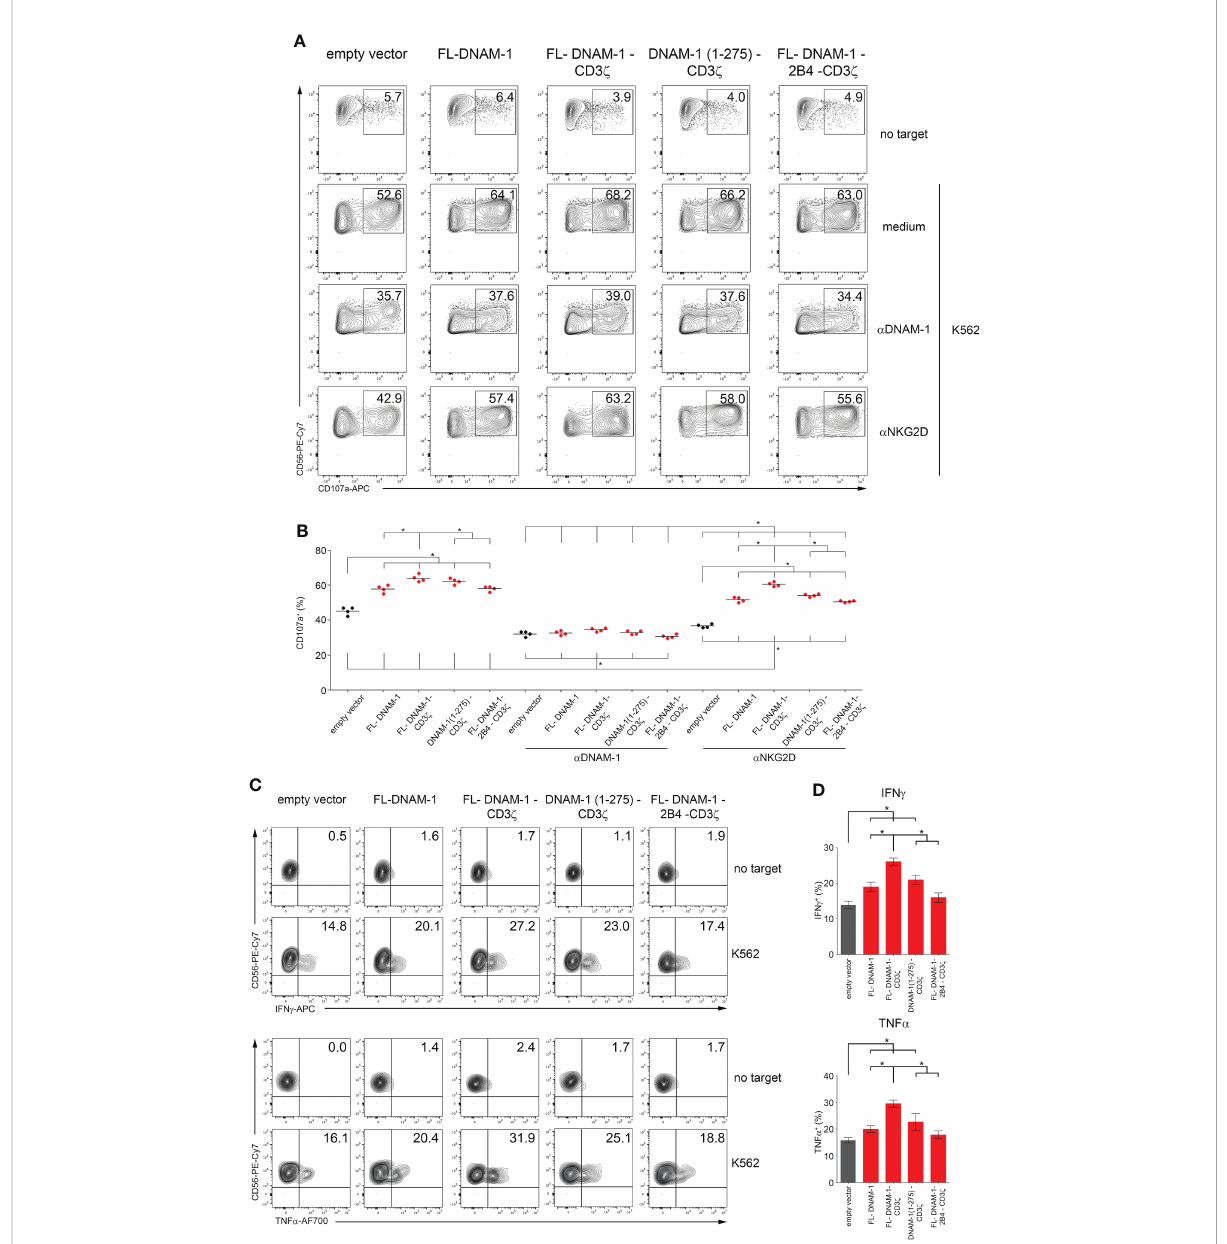
FIGURE 3 Enhanced degranulation and cytokine production of DNAM-1-engineered NK cells against K562. DNAM-1-engineered NK cells were tested for degranulation and cytokine production assays in response to K562. (A) Degranulation of NK cells engineered for the empty vector as control or for the four DNAM-1-based constructs as indicated, in the absence (medium) or presence of neutralizing anti-NKG2D or anti-DNAM-1 antibodies, measured as CD107a expression on co-culture with or without K562. The percentages of CD107a in NK cell subset are indicated in each plot. A representative experiment of four performed in NK cells isolated from independent healthy donors and transfected with DNAM-1- constructs is shown. (B) Summary of degranulation of NK cells isolated from four independent healthy donors, transfected with DNAM-1- constructs, in the absence or presence of neutralizing antibodies. Dots correspond to the percentage of CD107a + NK cells from each healthy donor transfected with the indicated DNAM-1-based constructs; horizontal bars indicate the mean; * p <0.05; p value (two-tailed nonparametric Mann-Whitney test). (C) DNAM-1-engineered NK cells production of IFN g and TNF a in co-culture with or without K562. The percentages of IFN g + and TNF a + in NK cell subset are indicated in each plot. A representative experiment of four performed in NK cells isolated from independent healthy donors and transfected with DNAM-1-constructs is shown. (D) Summary of cytokine production of NK cells isolated from four independent healthy donors and transfected with DNAM-1-based constructs. Mean ± SD; * p <0.05; p value (two-tailed non-parametric Mann-Whitney